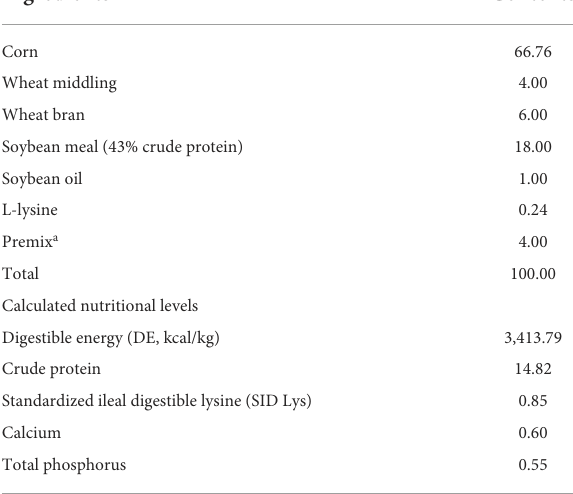
TABLE 1 Ingredients composition and nutritional levels of basal diets (air-dry basis,